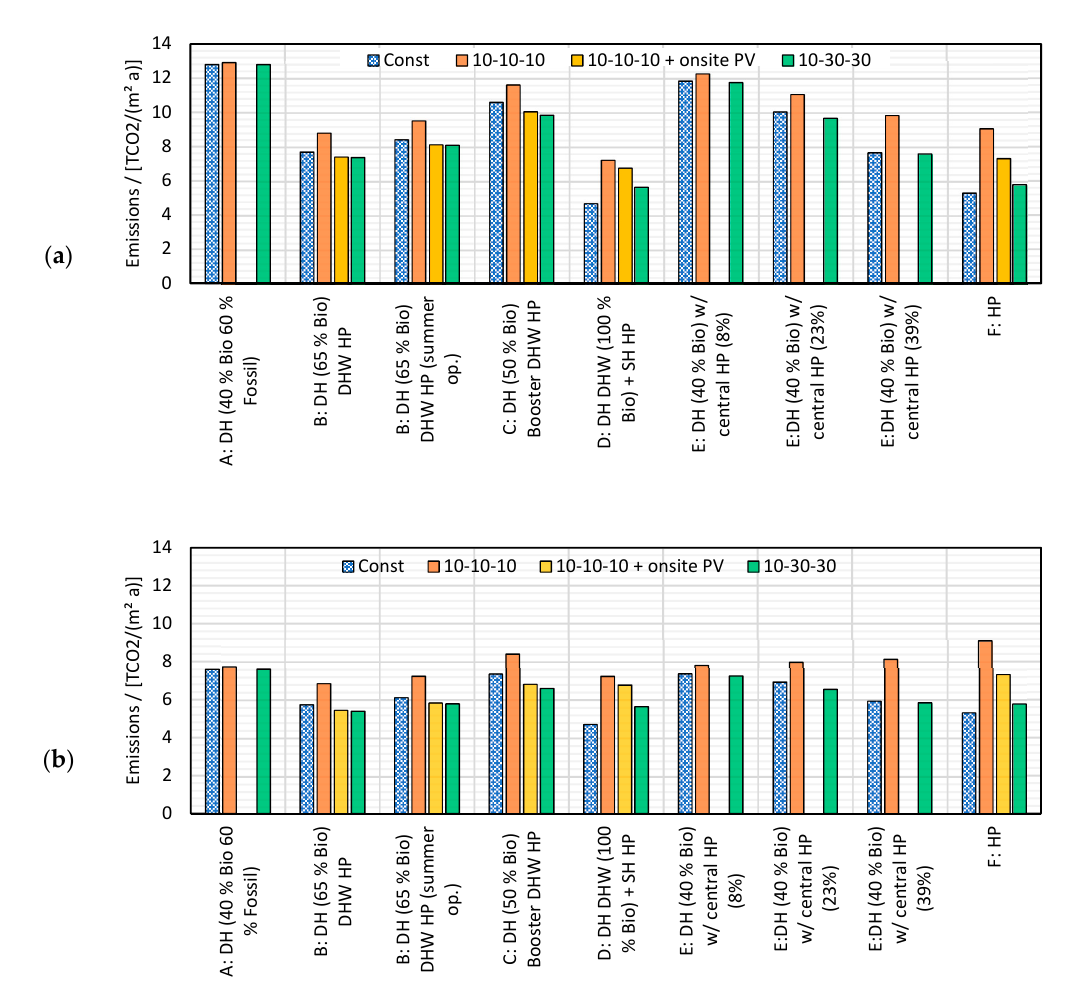
Figure 17. CO 2 emissions of the different systems considering different conversion factors for the electricity (i.e., Constant, 10-10-10 and 10-30-30) and the PV own-consumption. ( a ) represents the case in which the gas is directly used in the DH network and ( b ) the case in which all the gas is used in CHP power plants.